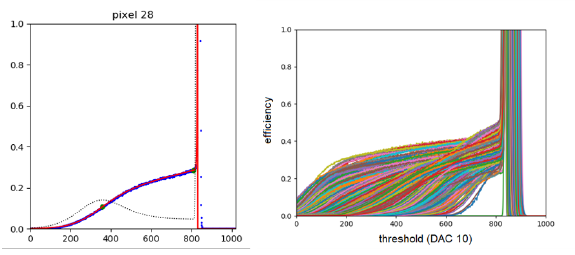
Figure 3. Left: S-curve for one pixel in DAC-10 mode. Verti- cal axis: e ffi ciency, horizontal axis: DAC-10 threshold. S-curve derivative (the dashed line) demonstrates one photoelectron peak. Right: S-curve plot for all (2304) pixels in DAC-10 mode with the adjustment of all pedestals thanks to proper DAC-7